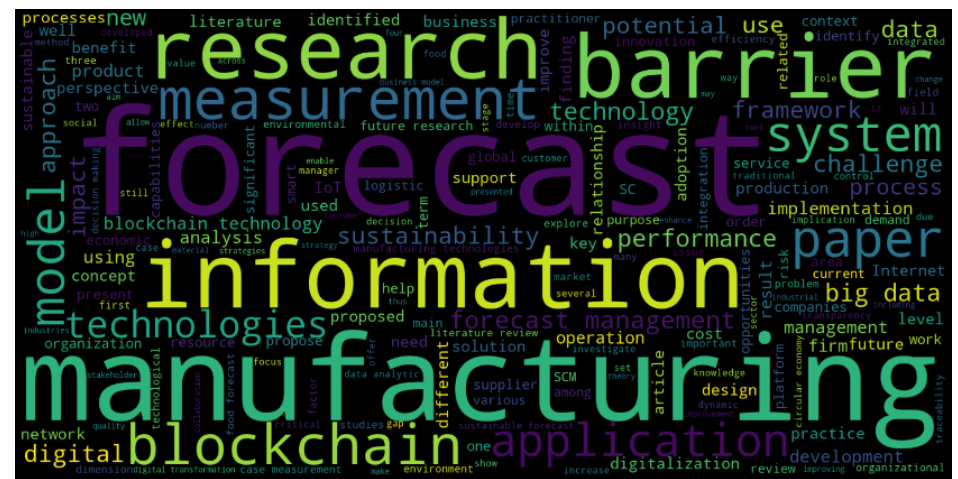
Figure 6. Word Cloud on “Abstracts”.